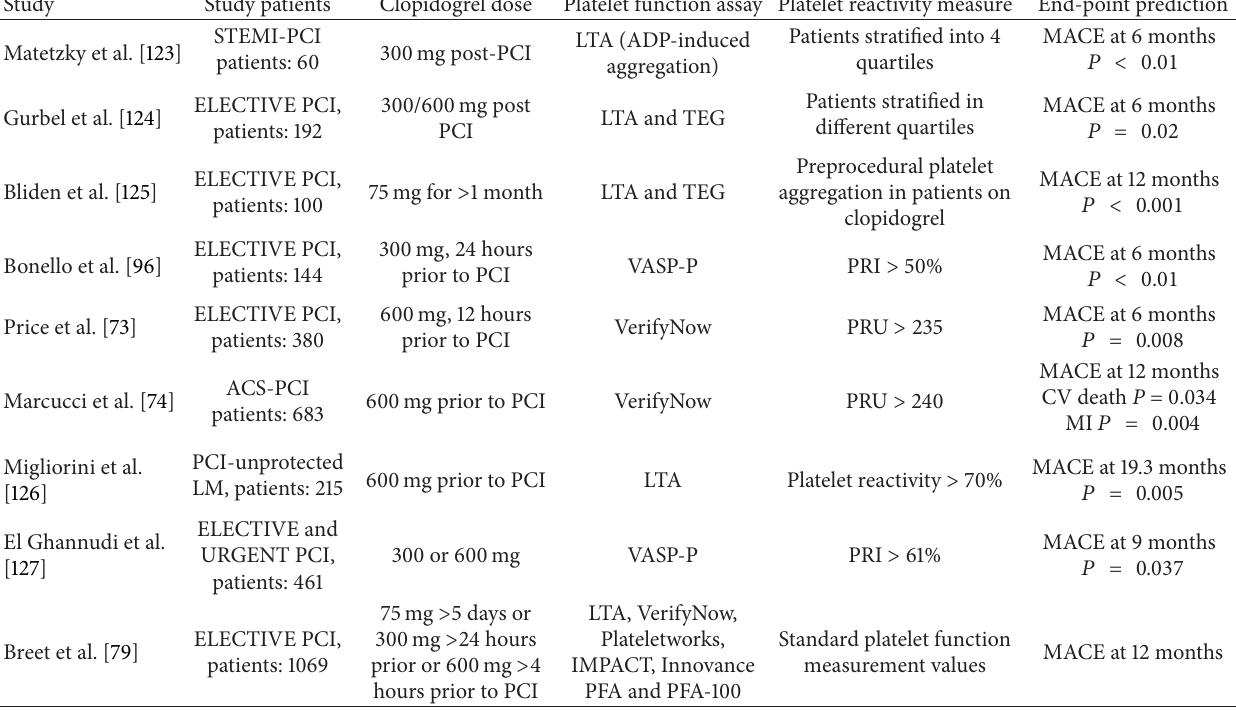
Table 3: Outcome studies with different inhibition of platelet